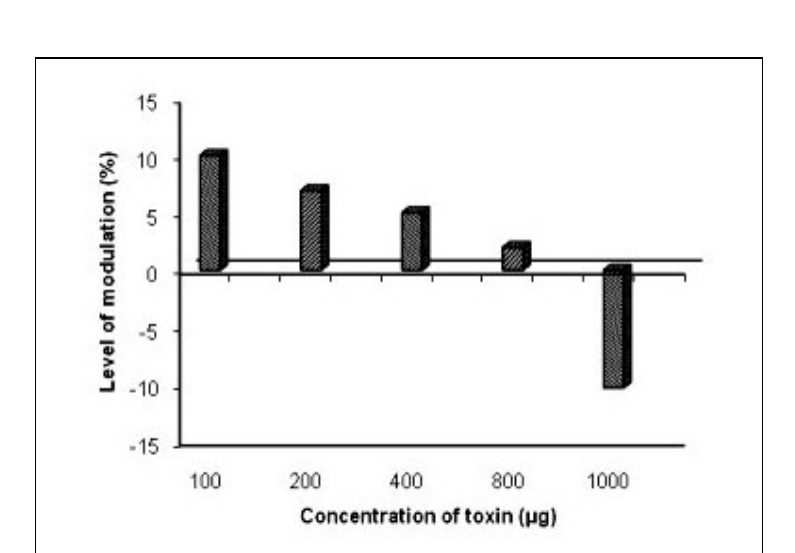
Figure 9. Immunomodulation produced by the aqueous extract of Halichondria panicea .